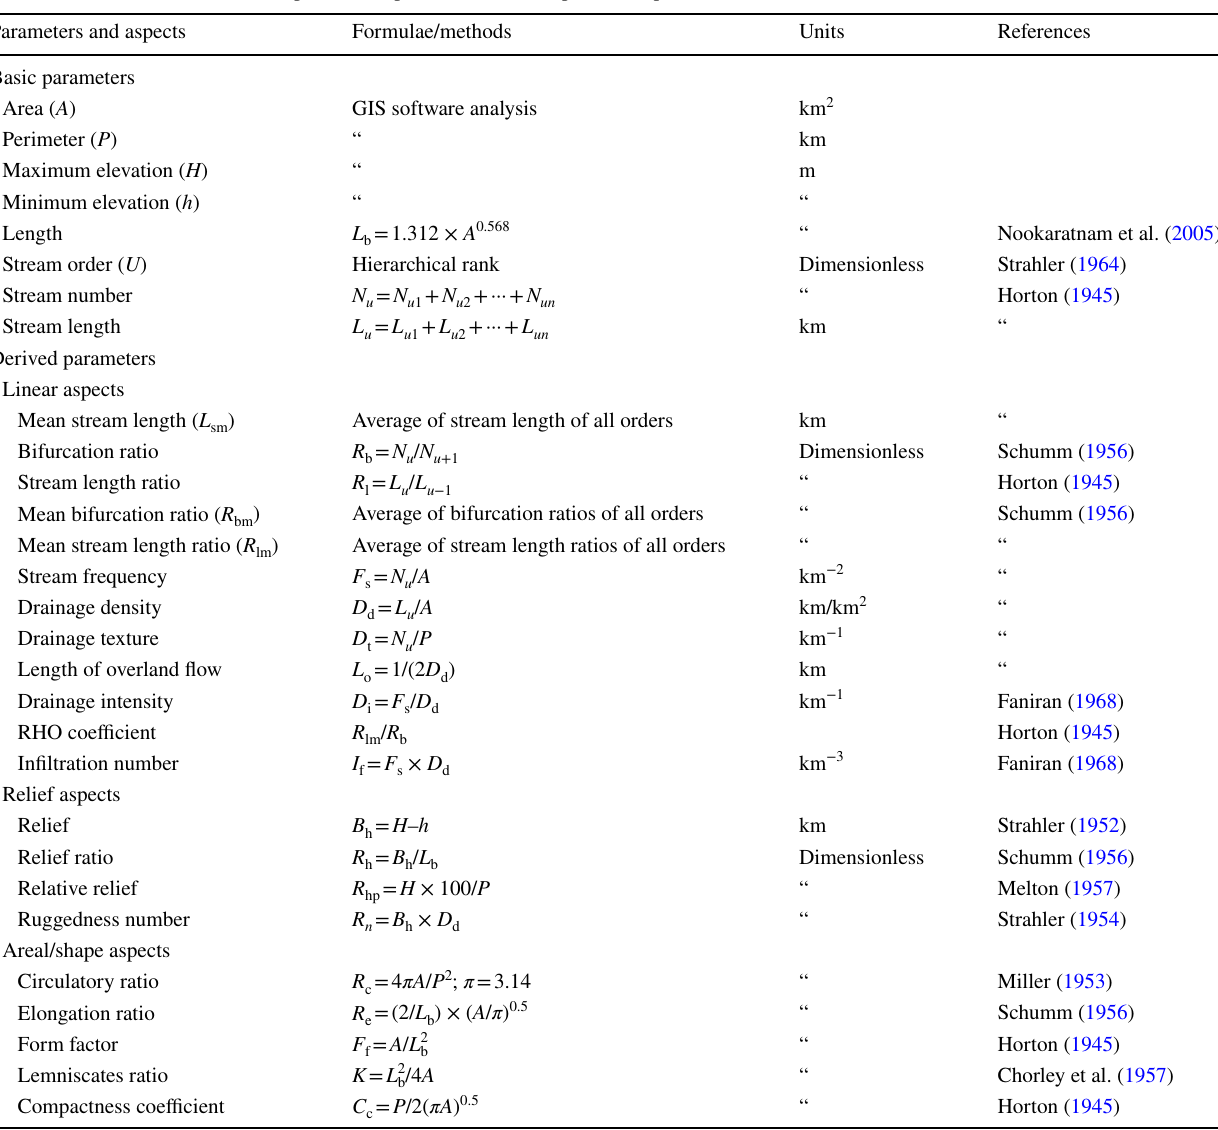
Table 1 Formulae and methods adopted to compute watershed morphometric parameters Parameters and